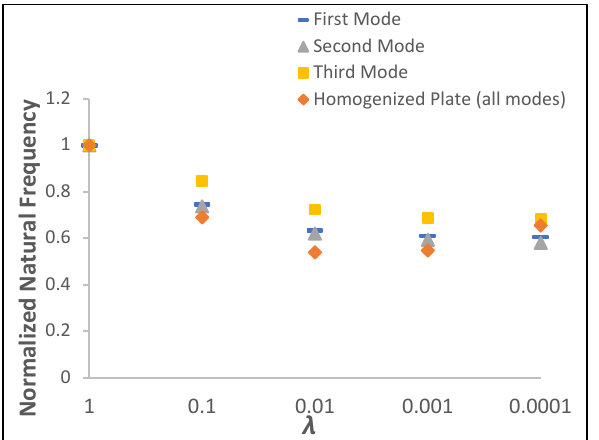
Figure 10. Effects of Young’s modulus ratio, λ , on natural frequencies of the bi-material plate. a = g = 5, s = t = 1, θ = 30 ◦ . Frequencies are normalized to the natural frequency of the plate with λ = 1 for the corresponding vibration